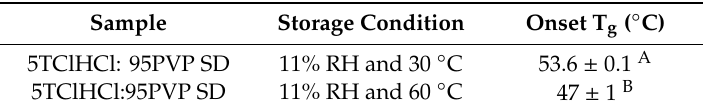
Table 3. Onset glass transition temperatures (T g ) of amorphous solid dispersions equilibrated at identified